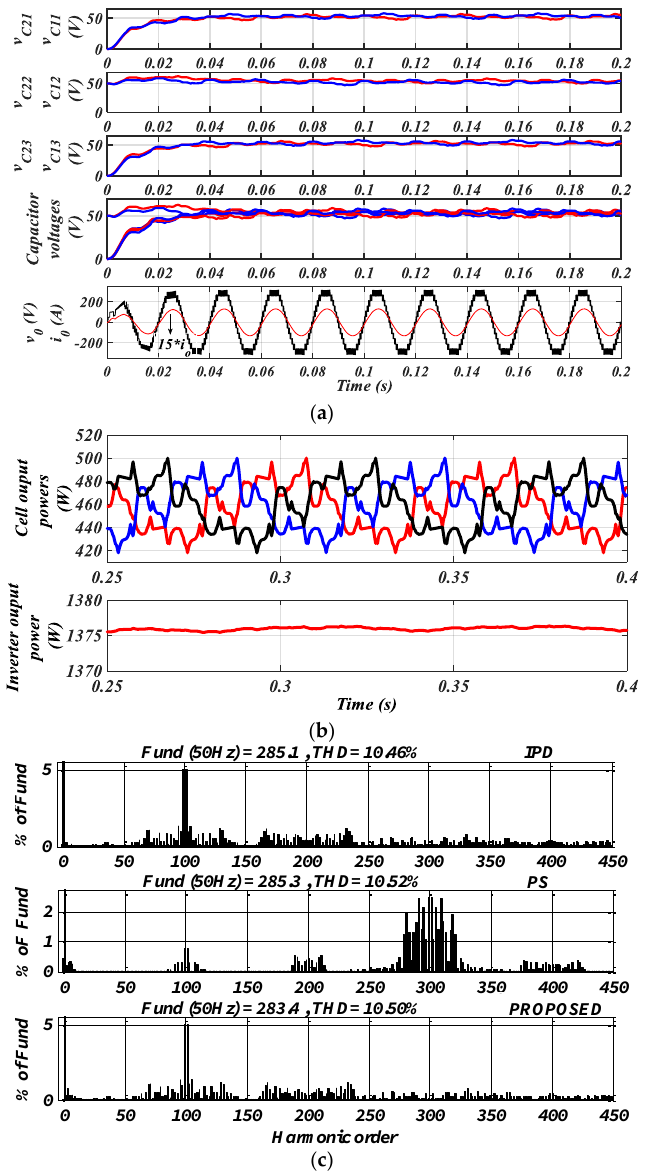
Figure 8. Simulated inverter output powers, FFT analyses of the output voltages from the considered modulation schemes. ( a ) Dc-link voltages for the three cascaded inverter units, ( b ) Individual cell output powers and overall inverter output power, ( c ) FFT analyses of the voltage waveforms from IPD, PS and proposed modulation strategy.